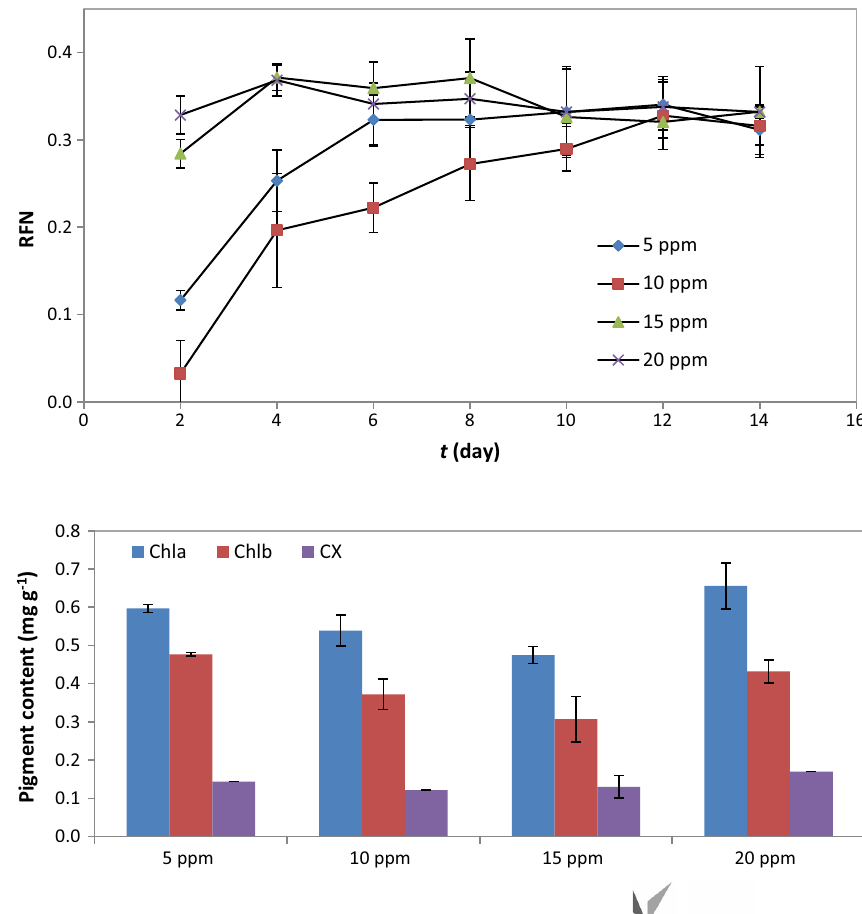
Fig. 6 RFN data of the phyto- extraction of various concen- trations of RB using AP over period of 14 days